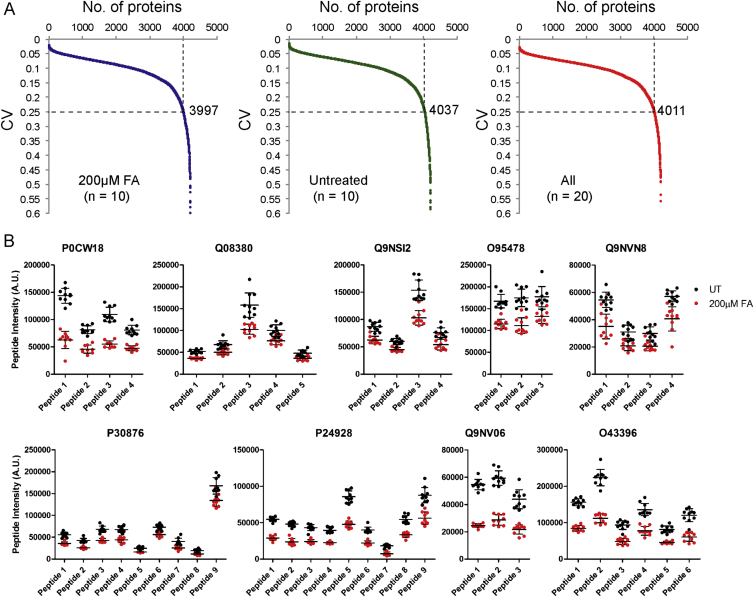
Related to Figure 4(A) Coefficient of variation (CV) distribution of the normalized SWATH intensities for FA-treated samples (left panel, 10 replicates), untreated samples (middle panel, 10 replicates), and all samples (right panel, 10 + 10 samples). The line of CV at 25% is illustrated by the horizontal dotted line.(B) Normalized peptide intensities of individual peptides in at least 8 out of 10 biological replicates of 9 representative proteins showing statistically significant depletion of protein abundances by more than 25% after formaldehyde treatment.